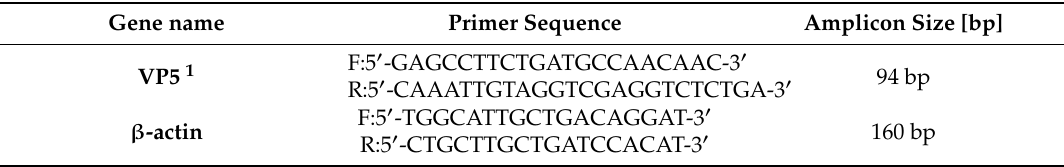
Table 3. Sequences of primers for the real-time